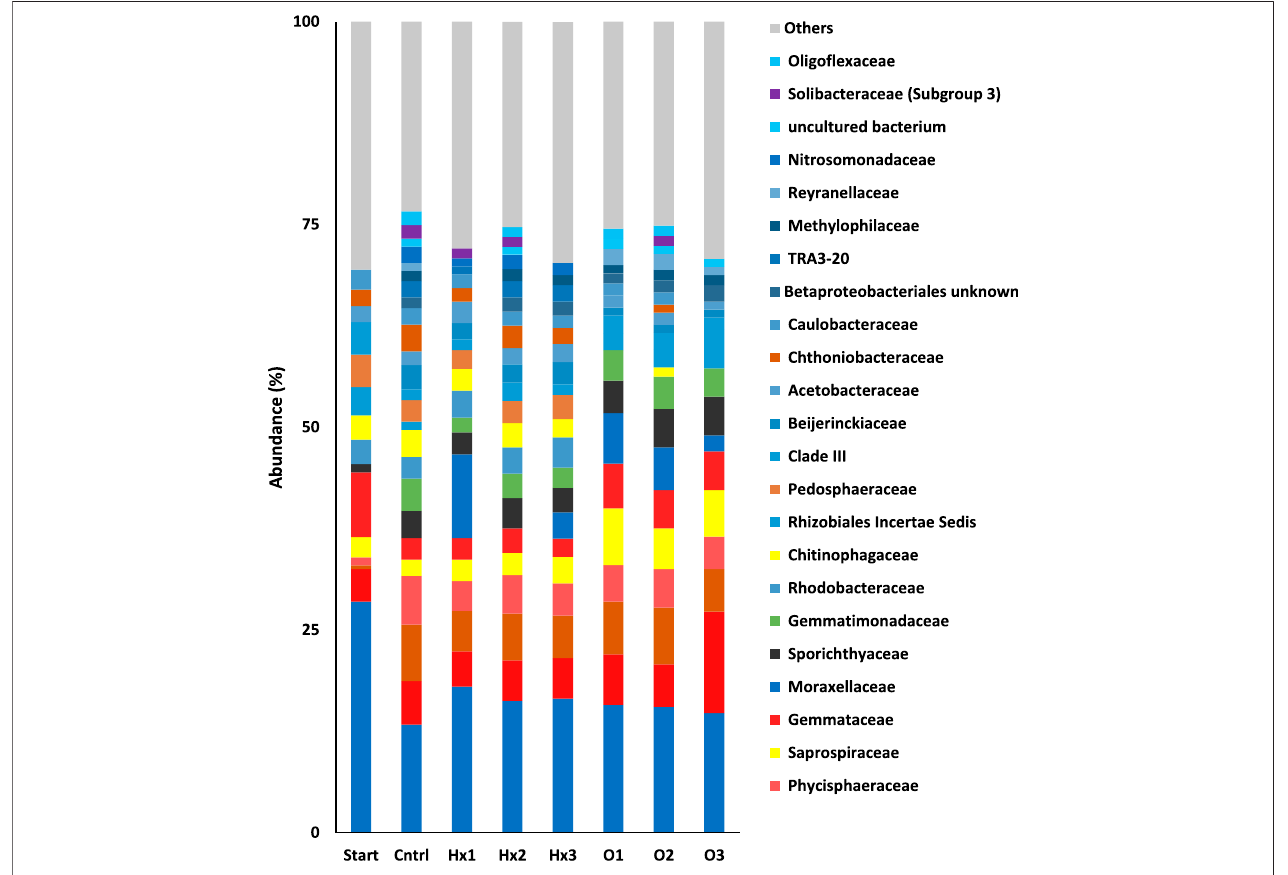
FIGURE 2 | The relative mean abundances of the families in the treatments. Others represent the sum of abundance of families with a combined abundance less than 1% across the whole data. Note that the families belonging to same class share the common base color.